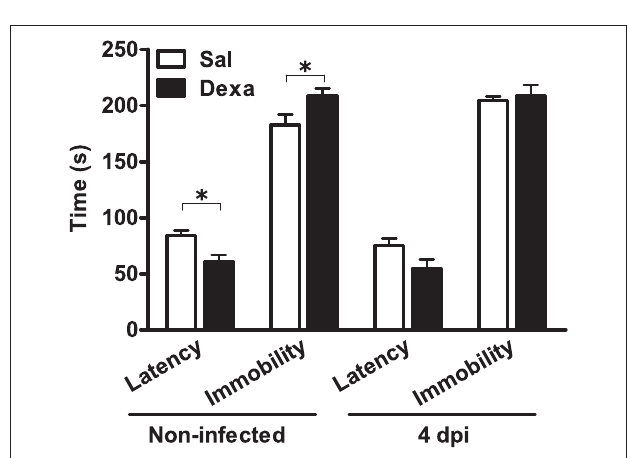
FIgure 9 | Infection with L. monocytogenes does not aggravate the depressive-like behavior of Dexa animals. Latency to first immobility and duration of immobility in the forced swim test were assessed in Sal and Dexa rats non-infected and 4 days after infection with L. monocytogenes (4 dpi). Each bar represents the mean + SEM from seven to nine rats per